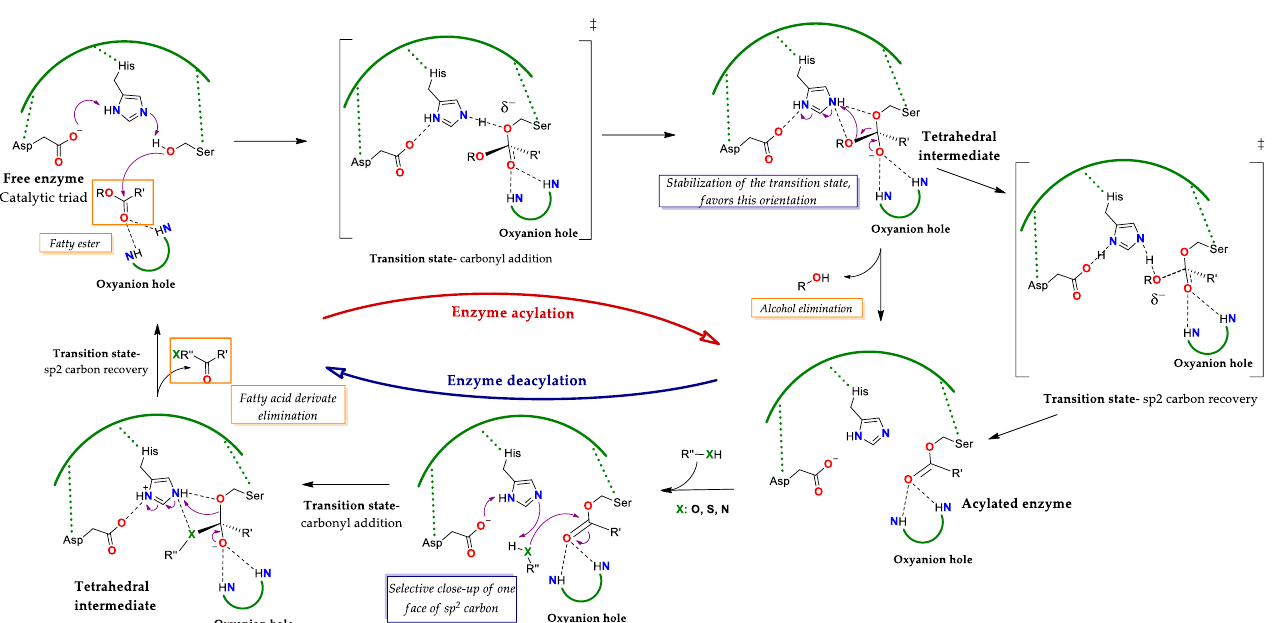
Figure 3. General catalytic cycle of lipases. The reaction starts by the nucleophilic attack of the catalytic Ser to the substrate, passing through a transition state (‡) of addition to the carbonyl to the generation of the selective tetrahedral intermediate (here, the R stereoisomer) where the negative charge density is concentrated in the O(β) of the Ser, here the preference towards the stereoisomer R is explained by the fact that the most stable transition state (‡) is the one where this orientation is favored. Next, the sp 2 carbon is recovered, through a transition state (‡) here the charge density is focused on the O of the alkoxy group to be eliminated, in order to obtain the acylated enzyme. Subsequently, in the presence of a nucleophilic molecule type RXH, where X can be O, S or N, a tetrahedral intermediate is regenerated, by the addition transition state (‡) to one face of the sp 2 carbon of the carbonyl. Finally, the sp 2 carbon is recovered, producing a fatty acid derivative and regenerating the free active site. Adapted from [18,83,84].